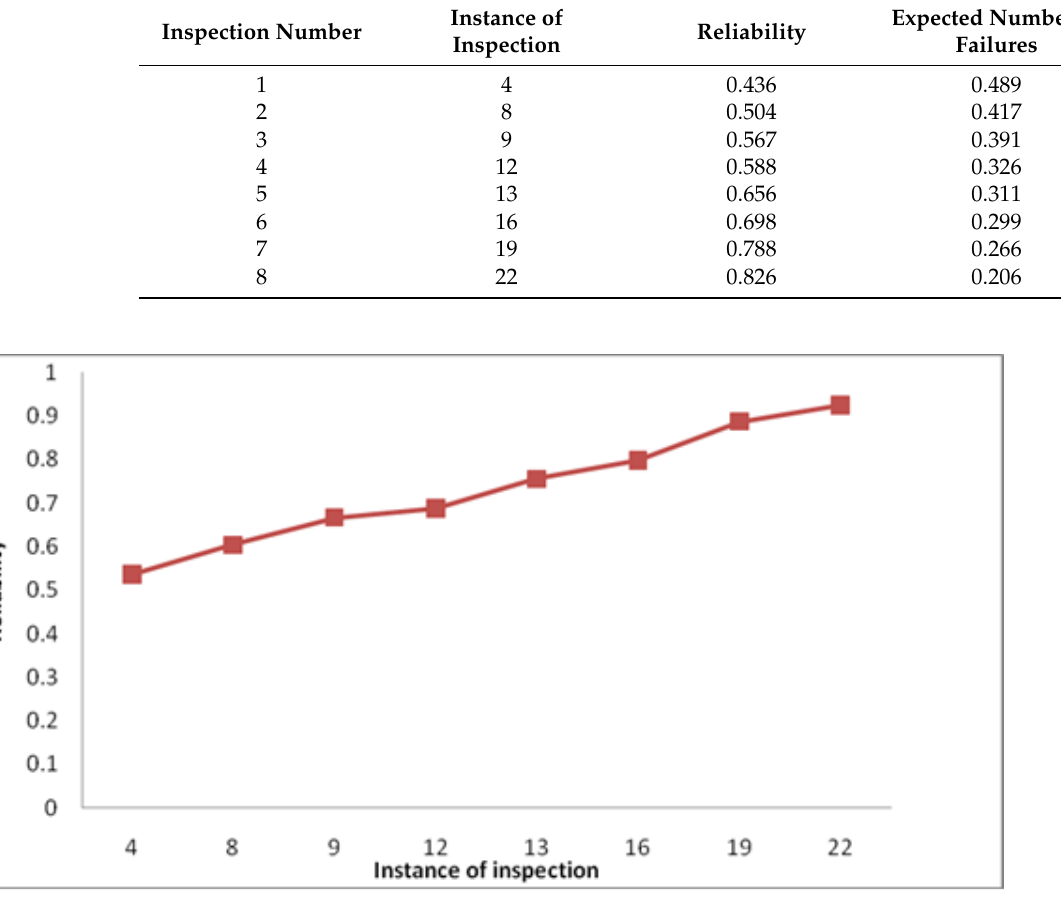
Table 3. Relationship between expected reliability and number of inspections.